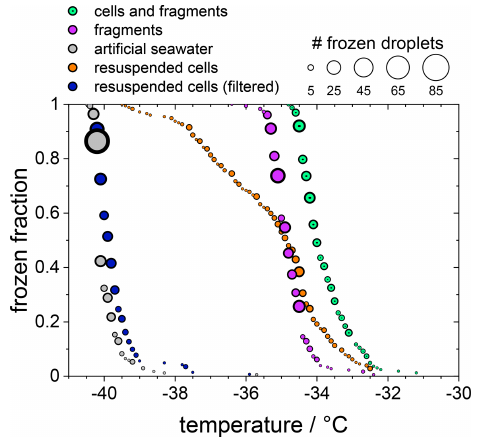
Figure 4. The frozen fraction of a sample with 1 × 10 7 F. cylin- drus diatoms per millilitre after different treatments. The symbol size indicates the total number of droplets frozen at that tempera- ture. The green coloured data are the untreated sample and are the same as those in Fig. 2a. The magenta data are the filtered sam- ple that should just contain fragments of the diatoms. These are the same data as the green data in Fig. 2b. The grey data points show the freezing of the artificial seawater for reference (also replotted from Fig. 2). The orange data show the freezing of the diatoms that were resuspended from the filter into artificial seawater. Its concentration is likely smaller than 1 × 10 7 cells per millilitre because not all cells could be resuspended. The blue data points represent the freezing of the droplets consisting of the resuspended cell suspension after renewed filtration; it should not contain any diatoms or fragments.